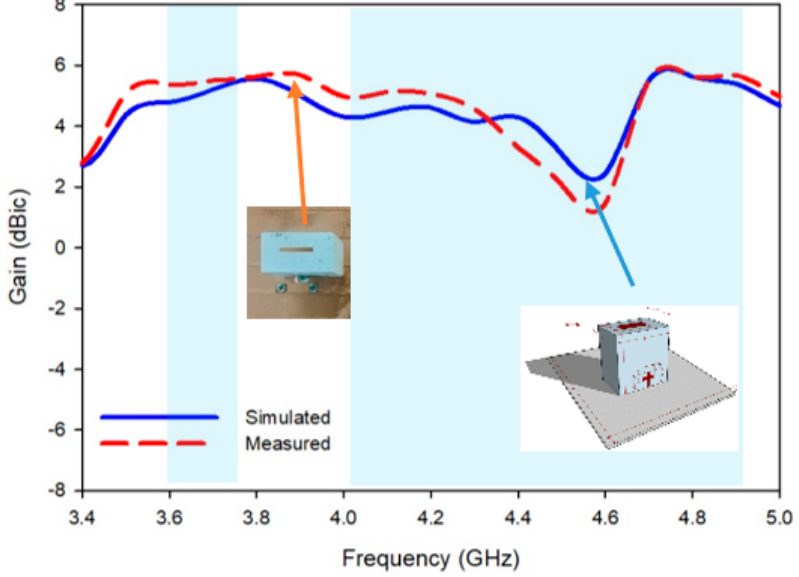
Figure 12. Simulated and measured gain over both bands.